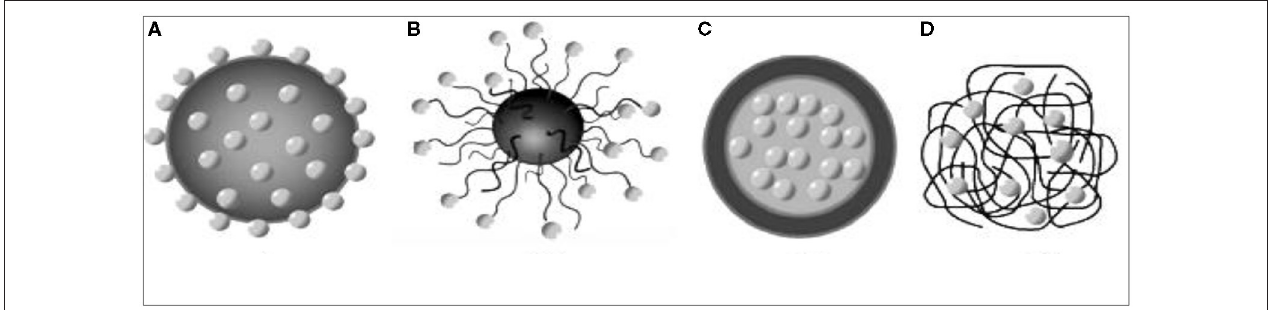
FIGURE 5 | Schematic representation of NPs for delivery of pesticides, (A) adsorption on NP, (B) attachment on NP by different linkers; (C) encapsulation inside polymeric hydrophobic or hydrophilic core (polymer micelles); and (D) entrapment inside polymeric nanoparticle [source: Athanassiou et al. (10)].